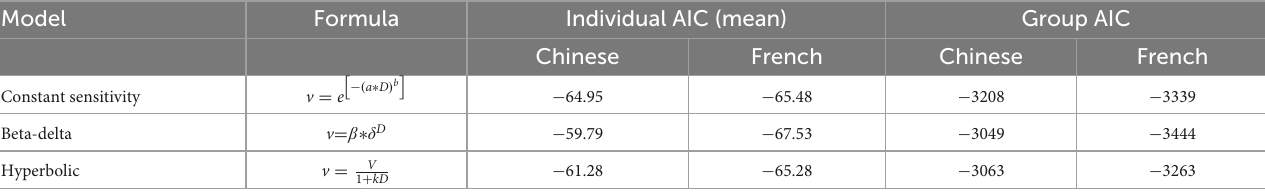
TABLE 4 Model selection according to AIC.